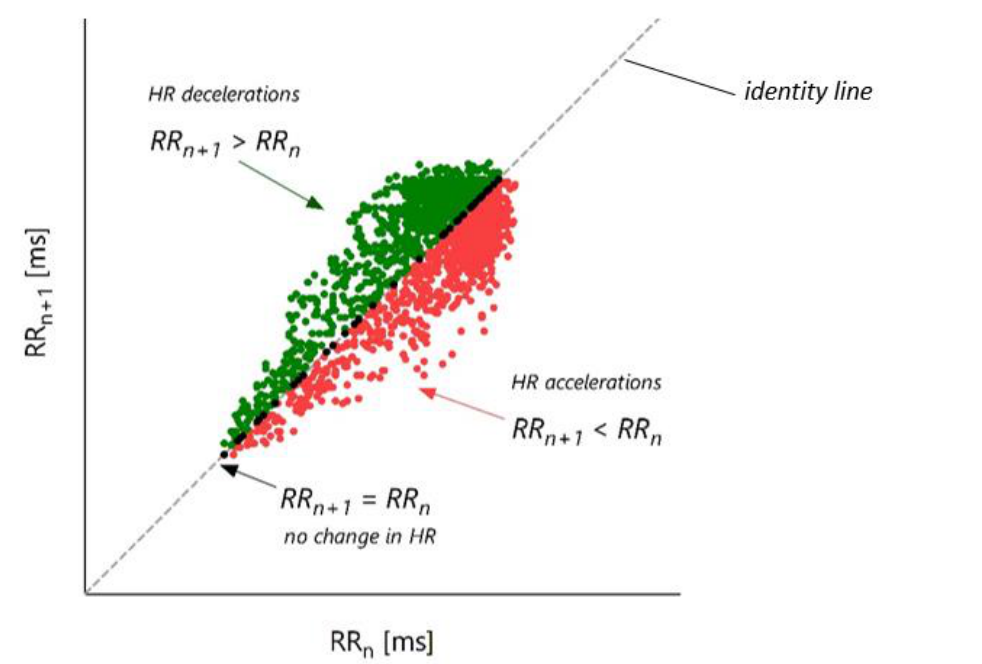
Figure 1. An example of the Poincar é plot of RR intervals. For clarity, instead of RR intervals from the 24-h ECG recording, which has, on average, 80,000–120,000 RR intervals, we present a set of RR intervals from a 30-min ECG. The whole plot is built by points described by pairs of two consecutive RR intervals, i.e., the current RR interval (RR n ) and the following next RR interval (RR n+1 ). The Poincar é plot of RR intervals in the space (RR n , RR n+1 ) has many interesting physiological properties. Points described by RR intervals of the same duration (RR n+1 = RR n ) (black dots) create the diagonal line (dashed grey line) termed the identity line. This line separates HR decelerations (green dots, RR n+1 > RR n ) from HR accelerations (red dots, RR n+1 < RR n ). Several variance-based descriptors describe the short-term, long-term, and total HRA [60 – 63,66].